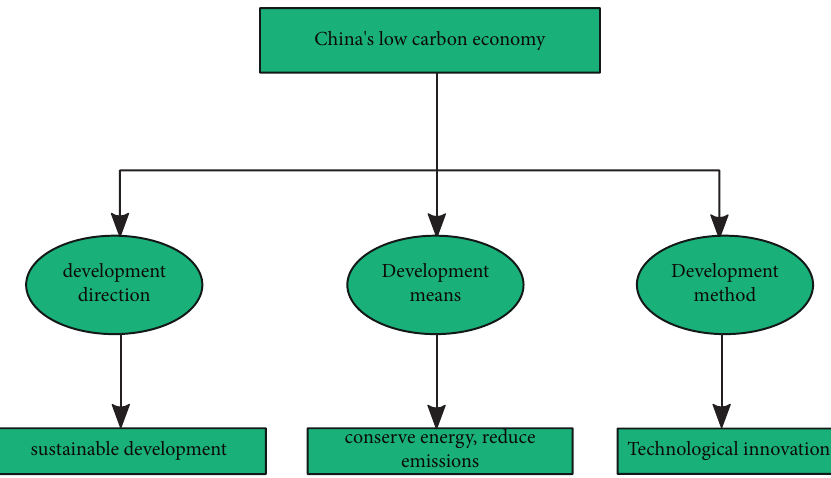
Figure 1: Low-carbon development